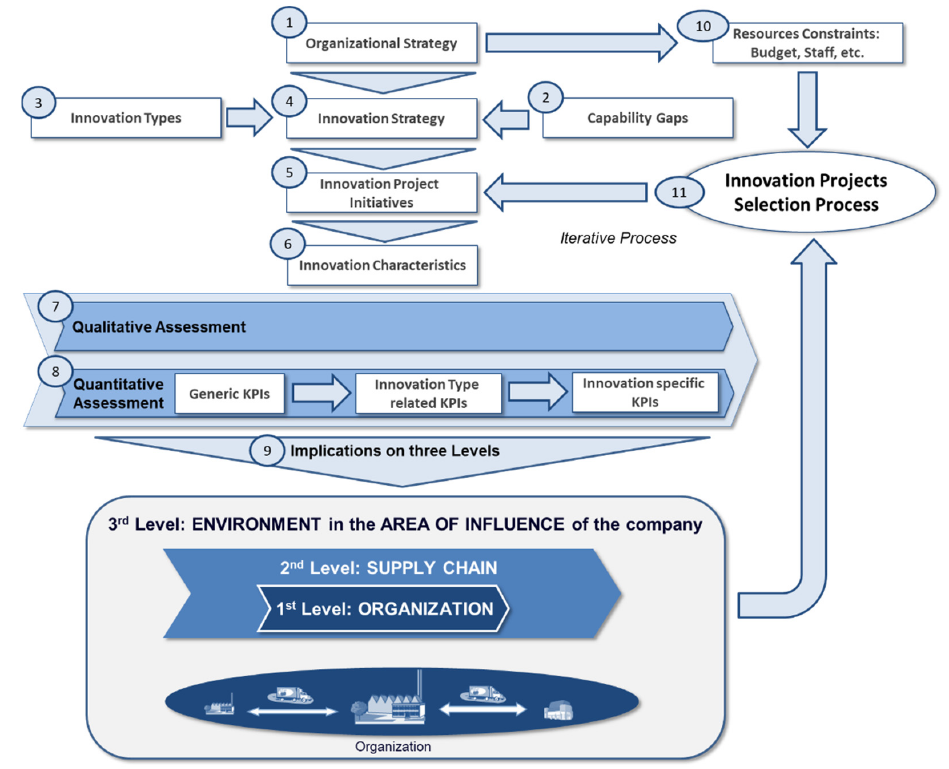
Figure 5. Project evaluation: three levels and 11 steps in an iterative process (own